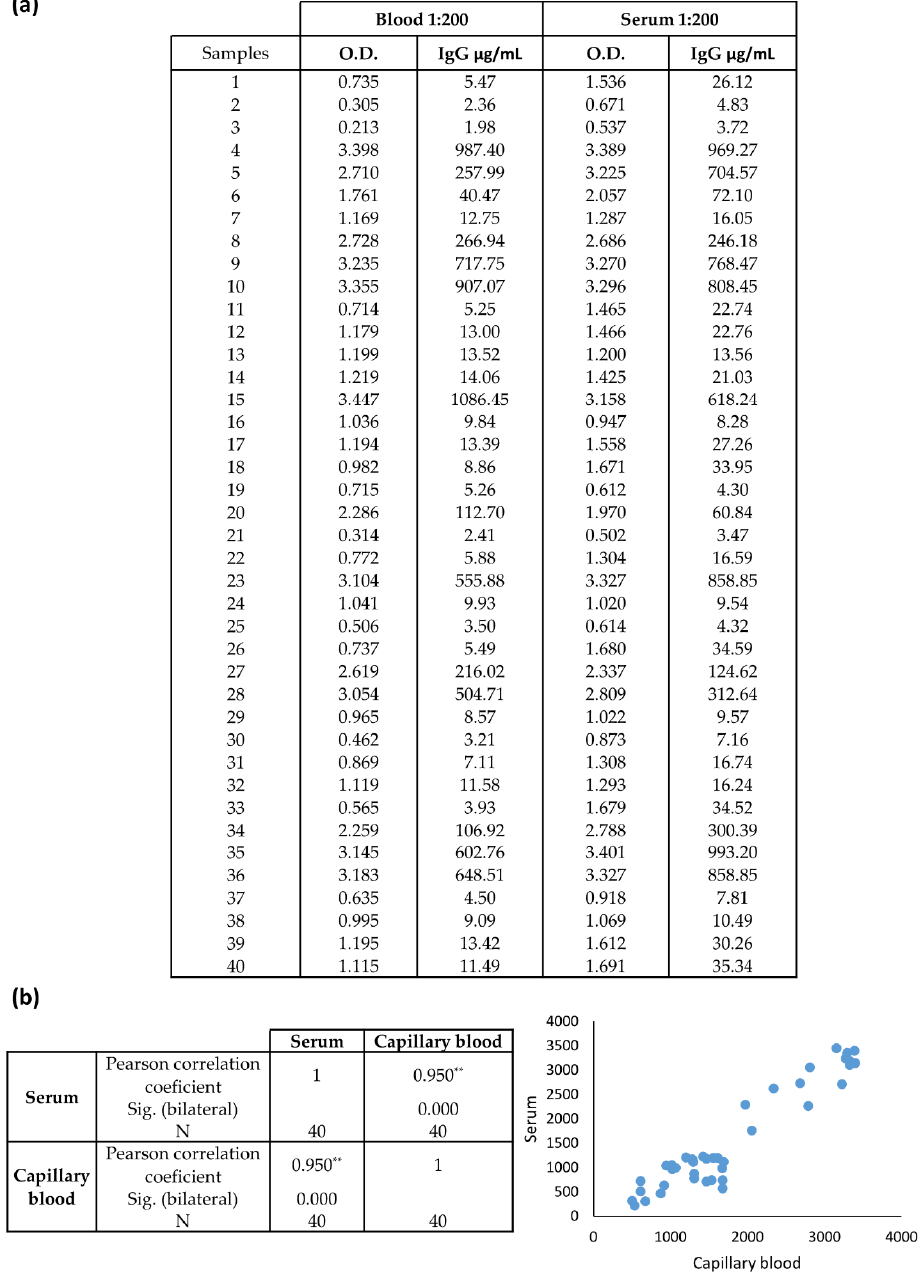
Figure 4. Comparison of determination of IgG in capillary blood and serum samples with the optimized ELISA-based serological assay. ( a ) Values of O.D. at 450 nm and the corresponding IgG concentration ( μ g/mL) shown in 40 samples. ( b ) The linear relationship between O.D. values of matched serum and blood capillary samples. ** Correlation is statistically significant at level 0.01 (bilateral).